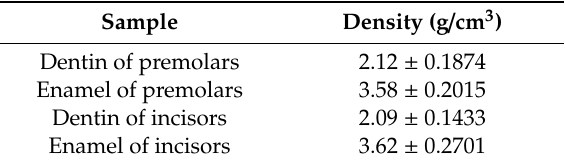
Table 5. Density of dentin and enamel for premolars and incisors.